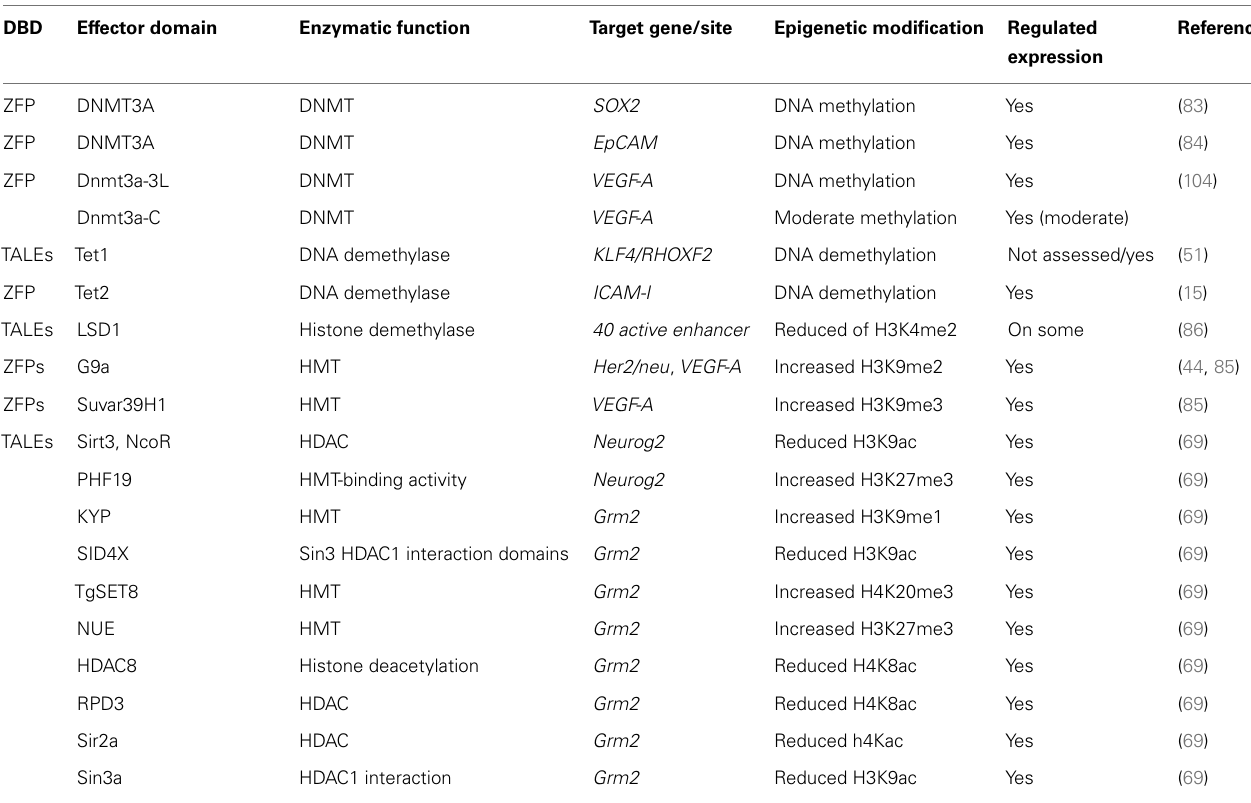
Table 2 | Epigenome editing using catalytic domains of epigenetic enzymes fused to DBDs